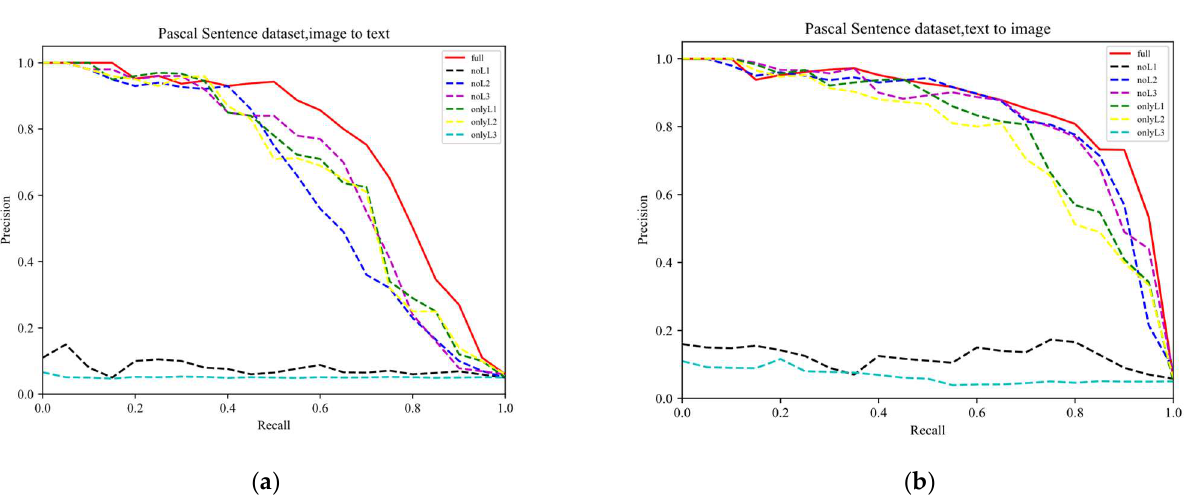
Figure 12. The PR curves of cross-modal retrieval performance on the Pascal Sentence dataset. ( a ) The image to text task on the Pascal Sentence dataset. ( b ) The text to image task on the Pascal Sentence dataset.